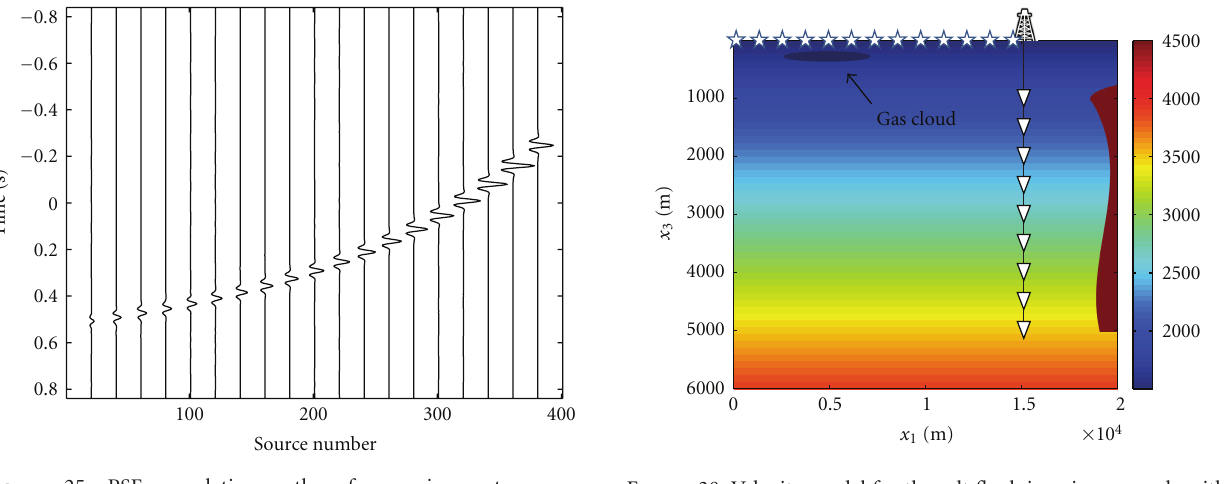
Figure 28: Velocity model for the salt flank imaging example with gas cloud.